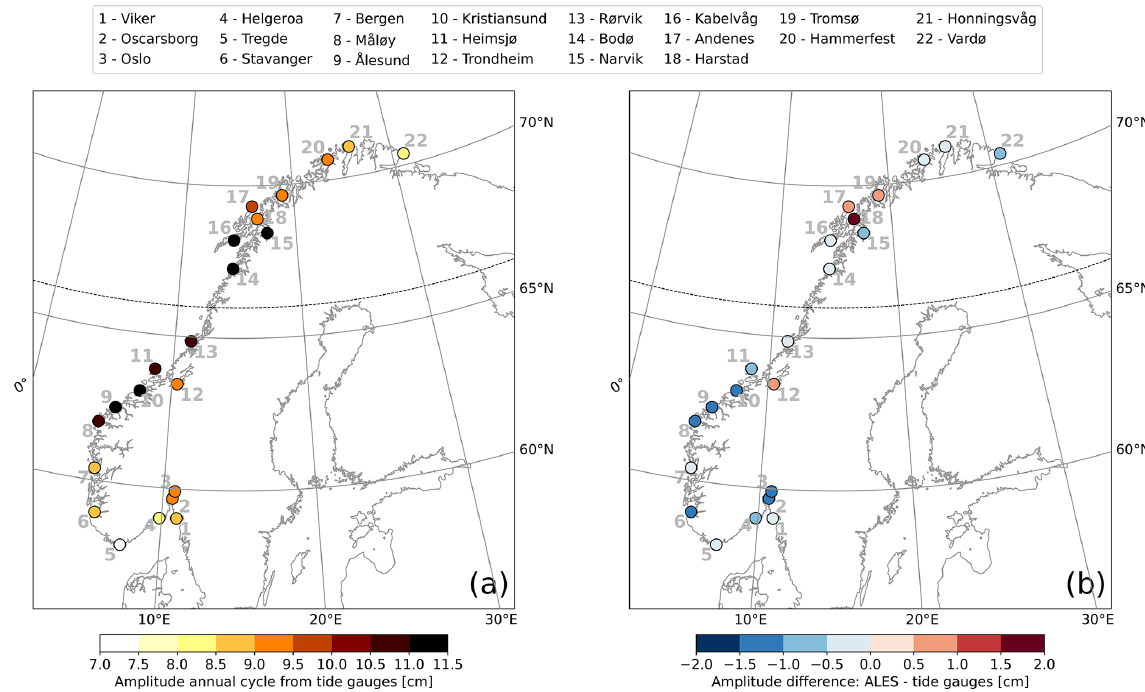
Figure 7. Comparison between the amplitude of coastal sea-level annual cycle from in situ measurements and area-averaged remote sensing data. At each tide-gauge location, the amplitude of the annual cycle from the tide gauges (a) and difference between the amplitude of the annual cycle from the ALES-reprocessed altimetry dataset and the tide gauges (b) . The black dashed line indicates the 66 ◦ N